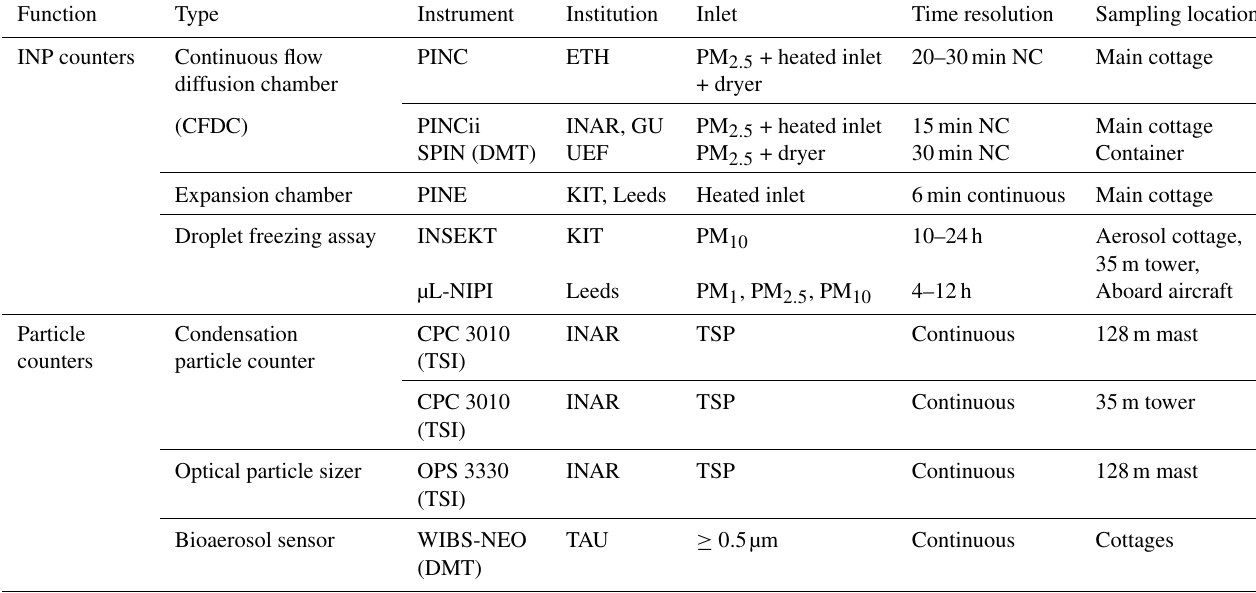
Table 1. Instrumentation installed at the SMEAR II research station specifically for the HyICE-2018 campaign. A list of the instruments permanently running at the SMEAR II research station can be found in Tables A1, A2 and A3, including the APS and DMPS which were used in this